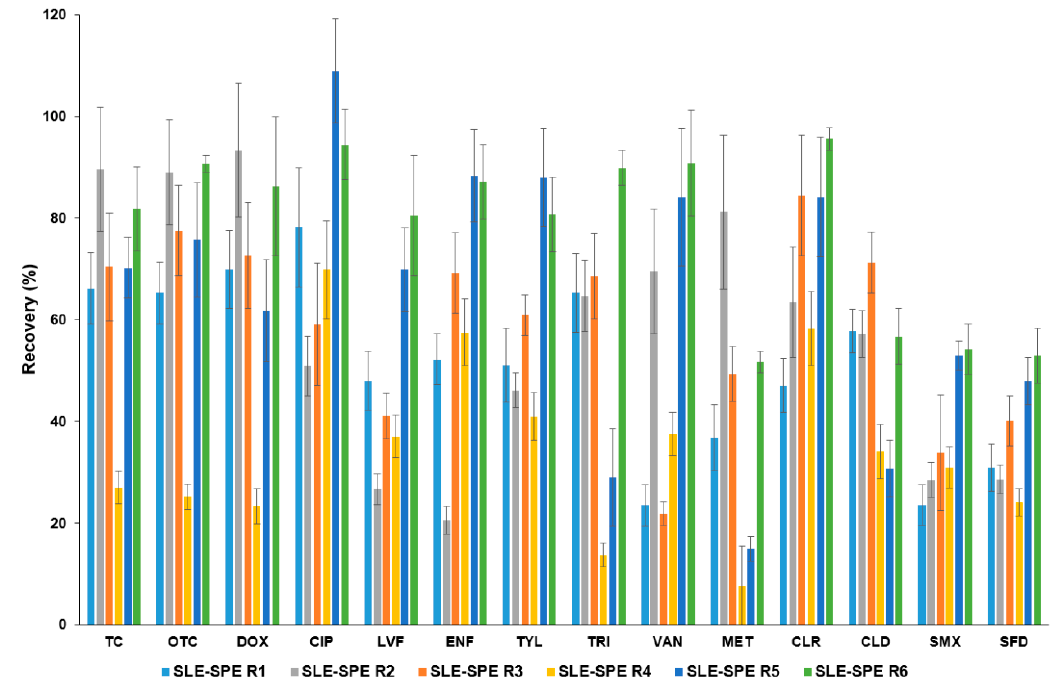
Figure 2. Comparison of efficiencies using SLE-SPE procedures for the separation of analytes from